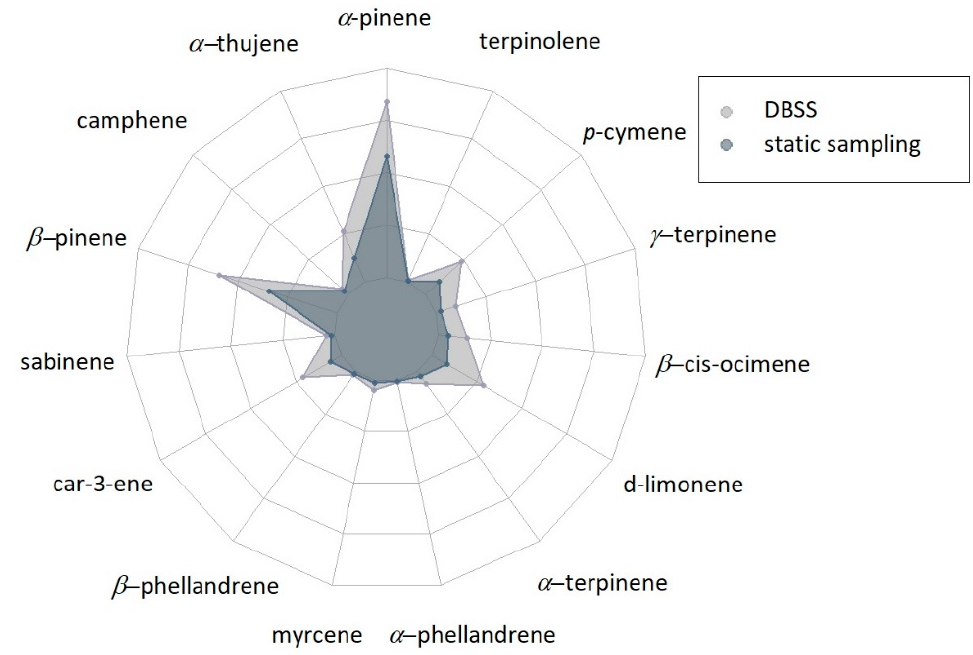
Figure 2. Radar-plot showing the results of the semi-quantitative analysis of BVOCs at sampling point 2 ( n = 3) expressed as the peak area of each individual compound. The amounts of different compounds range between 0 and 2,000,000. Results of statistical analysis are reported in Table S2.